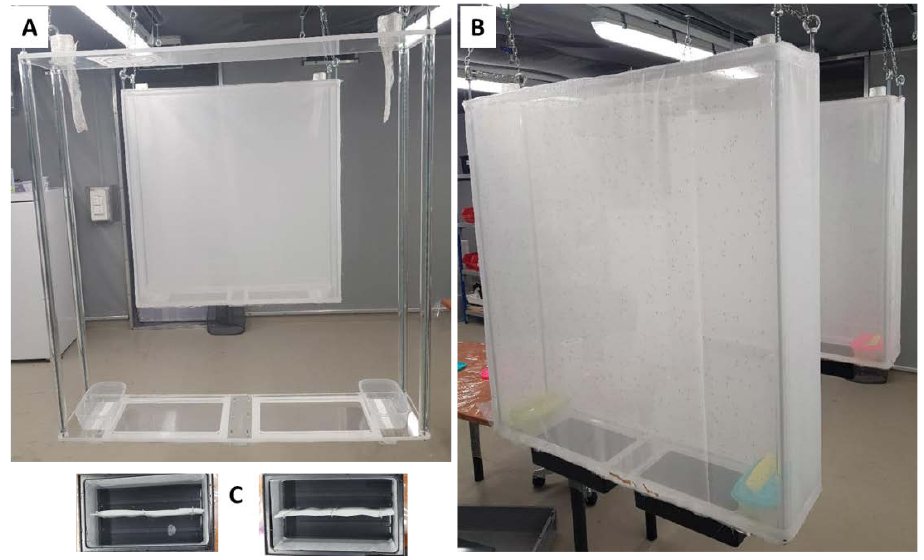
Figure 1. The structure of new mass-rearing cage (90 (L) × 90 (H) × 20 (W) cm) with the lower and the upper parts made of 1-cm-thick plates ( A ); the set-up with netting fixed with Velcro (VELCRO ® Freiberg am Neckar, Germany) ( B ); egg papers lining the walls of two black containers that can be removed laterally ( C ).